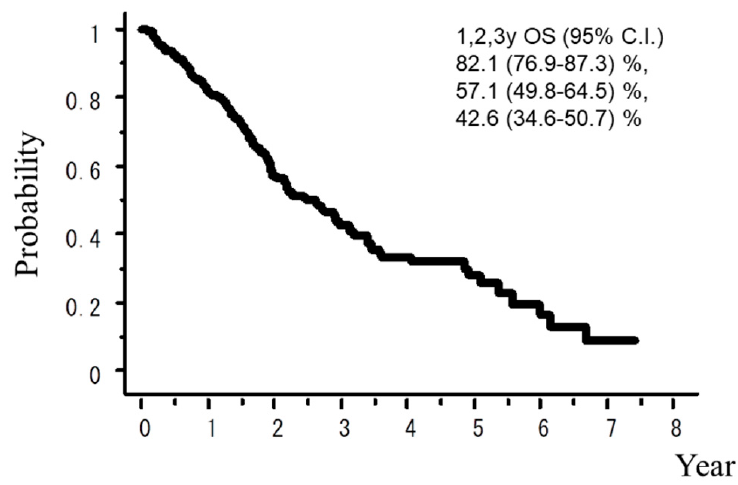
Figure 1. Overall survival (OS) rate.